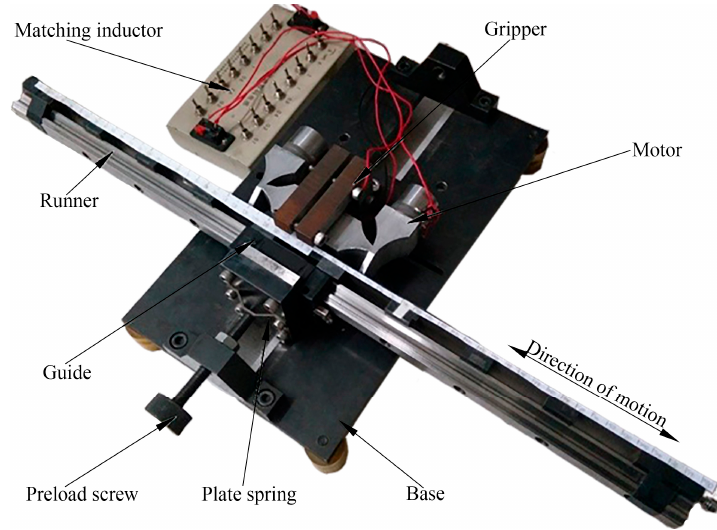
Figure 7. The prototype and experimental platform of the proposed PUM.